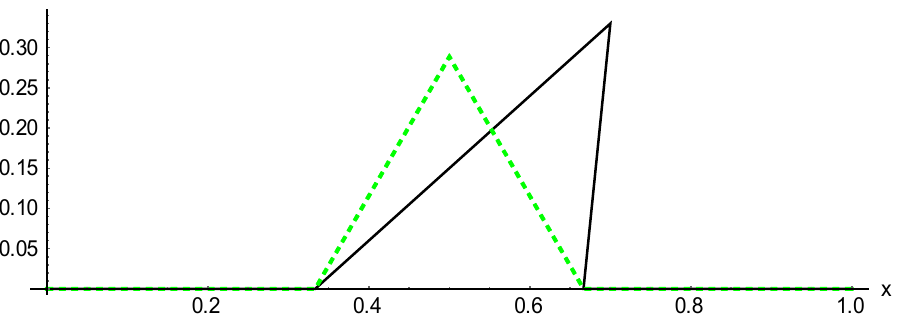
Figure 1. First iteration. Black solid line for the Koch-type fractal, green dashed line for the classical Koch fractal.